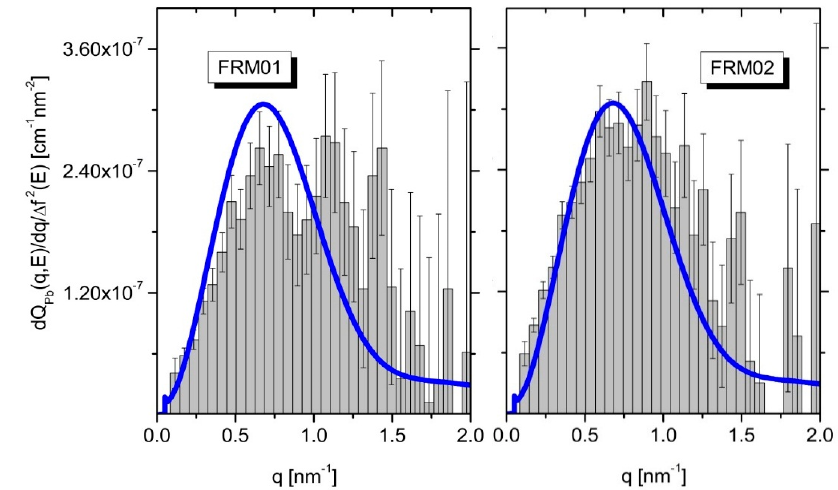
Figure 2. The resonant invariant of the Pb counterions. From the integral the Pbconcentrations in the condensed phase is deduced. The blue lines represent the FJC-PN model (see text).